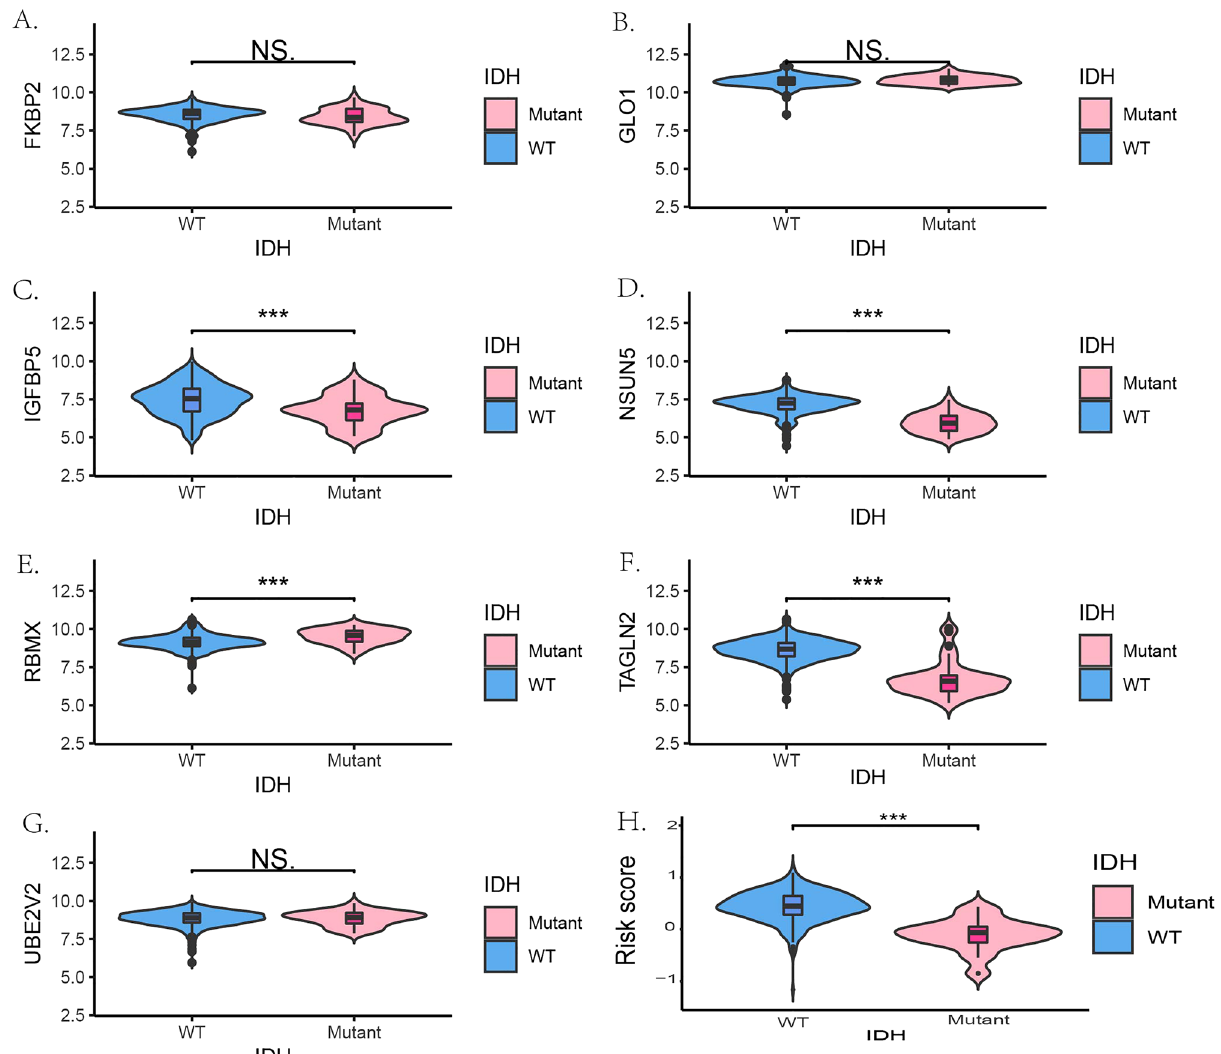
Figure 5. The gene expressions of seven genes between IDH WT and mutant patients in TCGA. ( A – G ) FKBP2, GLO1, IGFBP5, NSUN5, RBMX, TAGLN2 and UBE2V2 , respectively. *** p < 0.001. WT wild